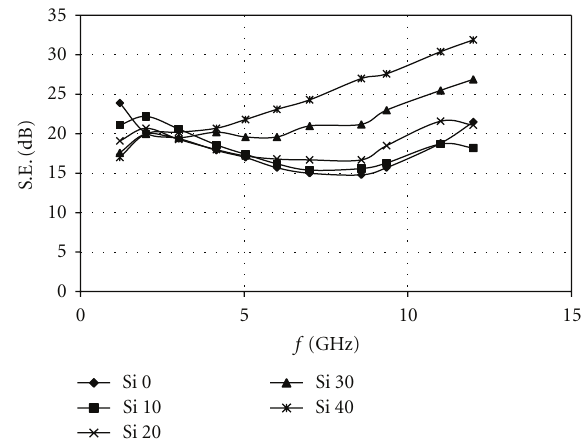
Figure 10: Frequency dependence of shielding e ff ectiveness at various filler content in the composites.